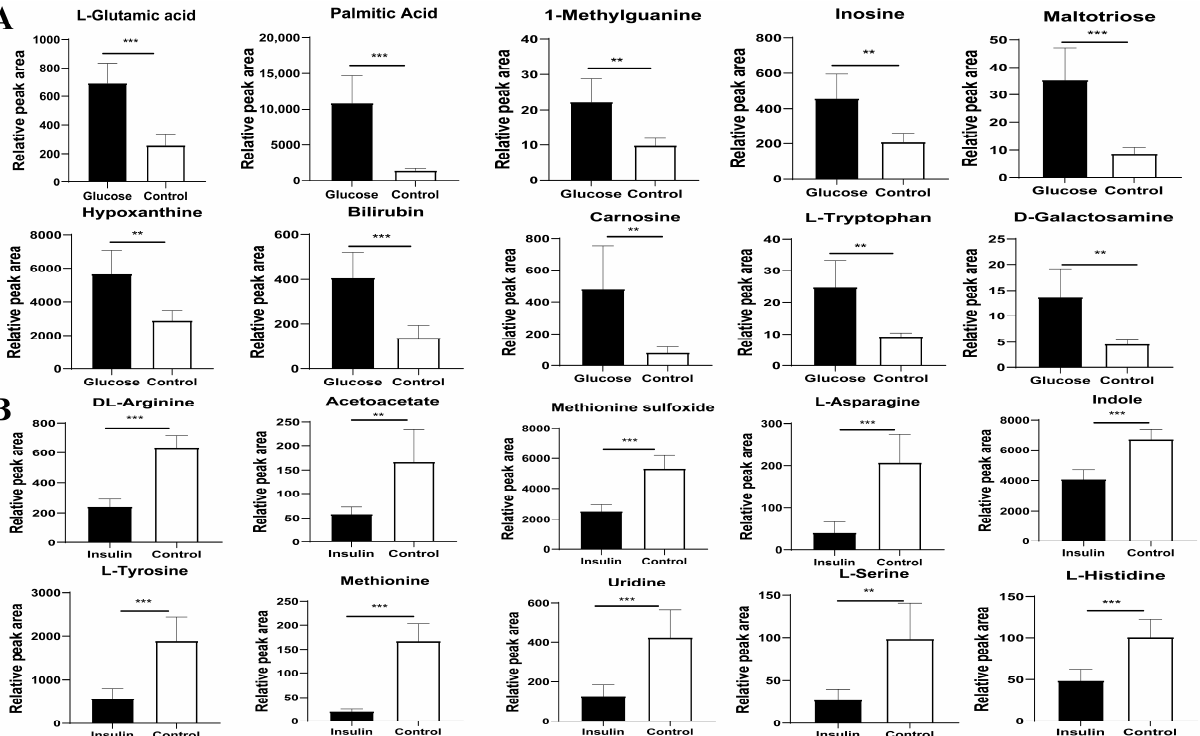
Figure 7. Differential metabolites of acute hyperglycemic/hypoglycemic chickens and control birds. ( A ) Peak area of representative key metabolites regulating blood glucose rise. ( B ) Peak area of representative key metabolites regulating blood glucose decline. All values of ( A , B ) are mean ± SE n = 6 chickens per group, with ** p < 0.01, *** p < 0.001, determined by Student’s t -test.